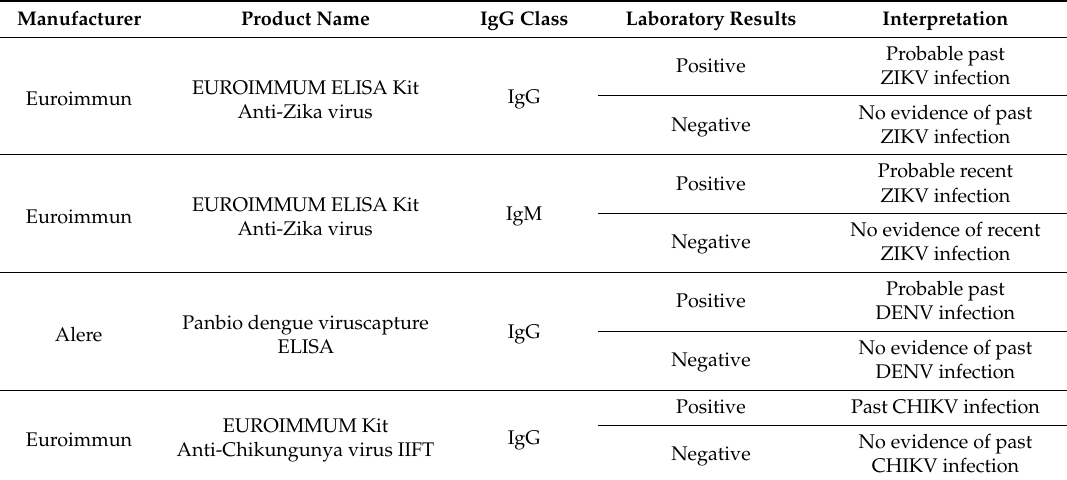
Table 3. Laboratory results